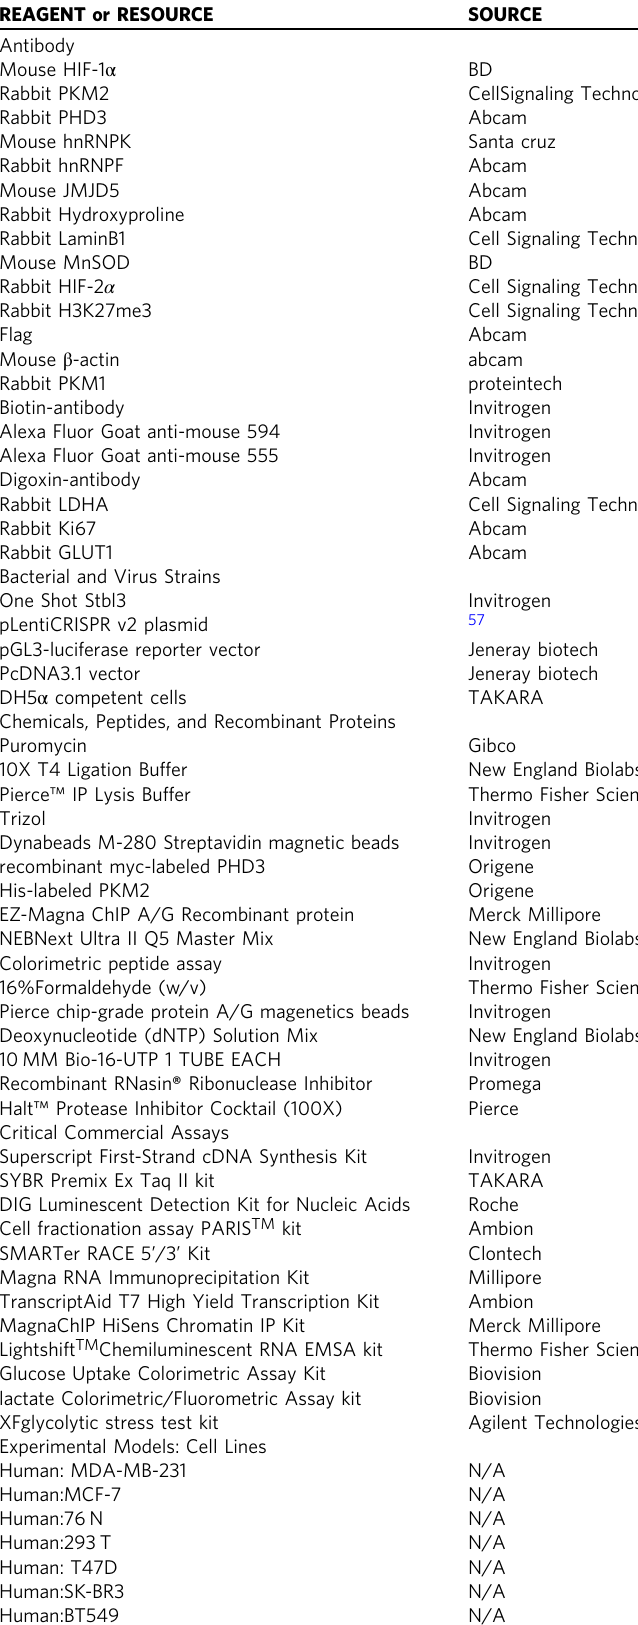
Table 1 Key resources